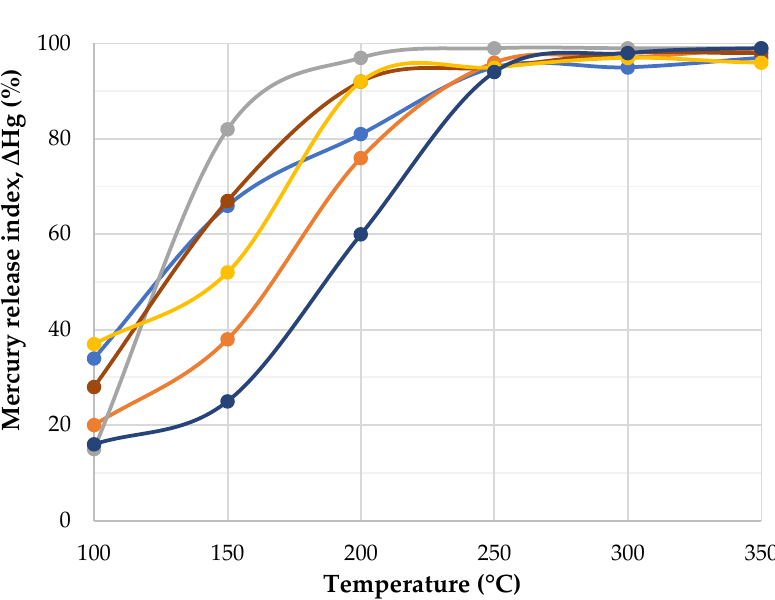
Figure 2. Release of mercury from the RDF samples during thermal pretreatment (purge gas flow: 500 cm 3 /min; residence time: 30 min).